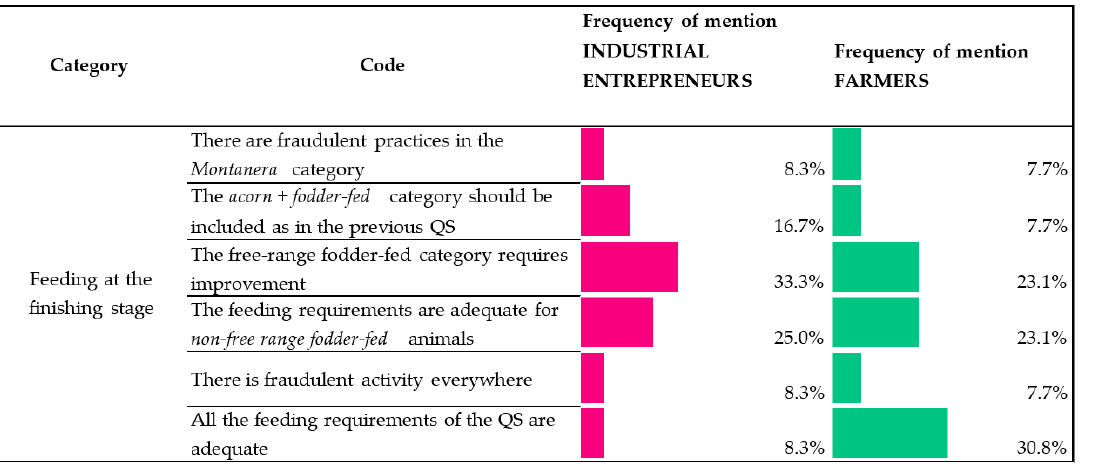
Figure 4. Industrial entrepreneur/farmer views on the QS (Quality Standard) feeding requirements. (Scale: frequency of mention of each opinion. Percentage is based on responses in the given code out of all responses to equal 100%).